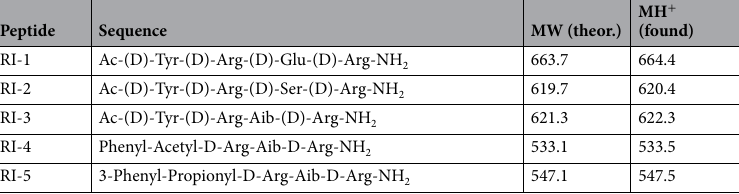
Table 1. Sequence of the RI peptides used in this